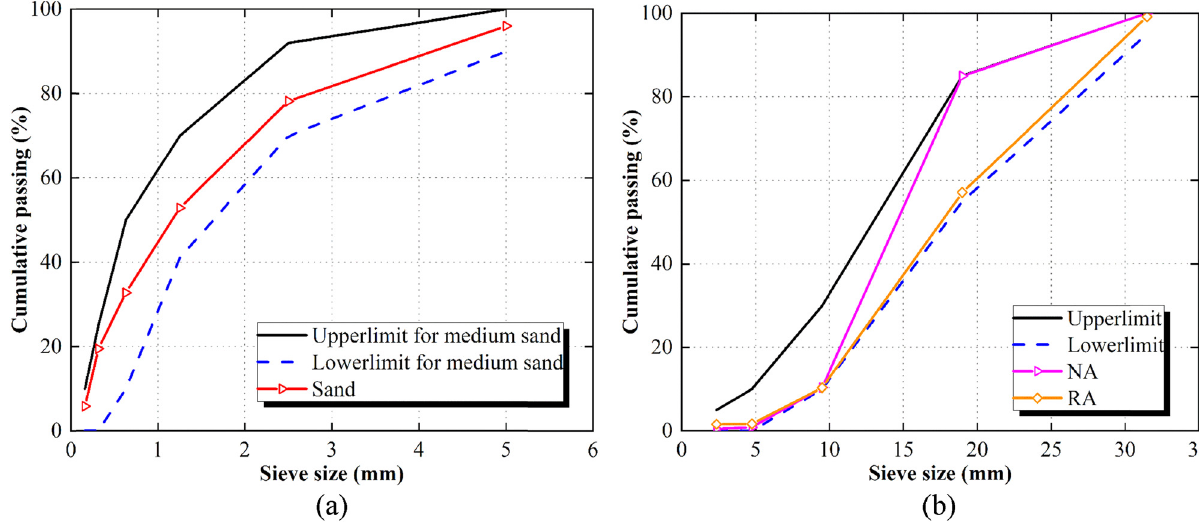
Figure 1: Grading curves of aggregates: ( a ) fi ne and ( b ) coarse aggregates.